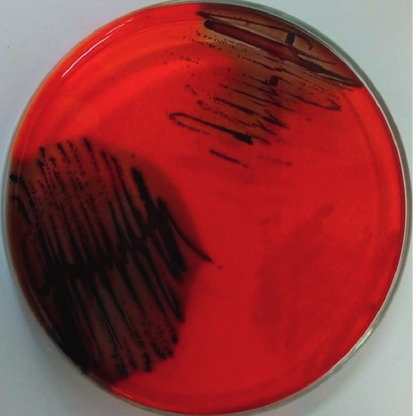
Figure 1: Biofilm production by coagulase-positive staphylococci isolated from the oropharynx of Rupornis magnirostris and Ca- racara plancus by the red Congo agar method after 24 hours at 35 °